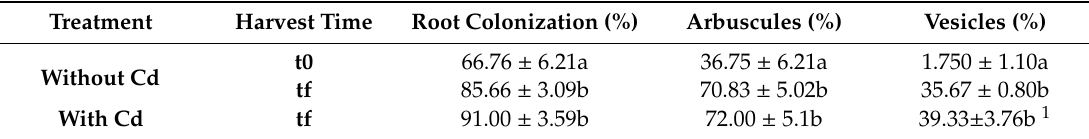
Table 1. Mycorrhizal colonization of soybean plants inoculated with Rhizophagus intraradices supplemented or not with Cadmium (Cd).